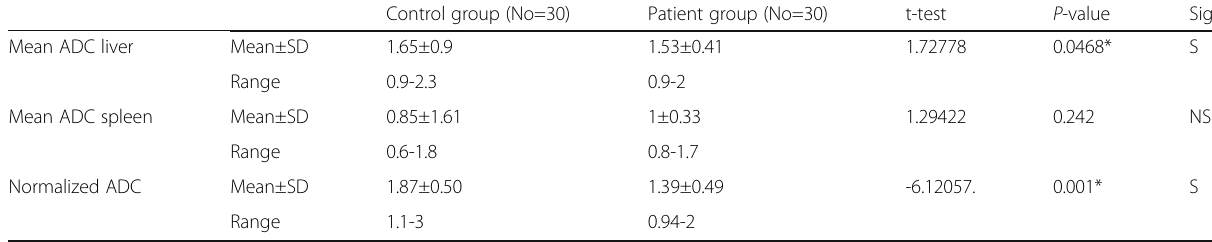
Table 2 Mean liver and spleen ADC and nADC in control and patients ’